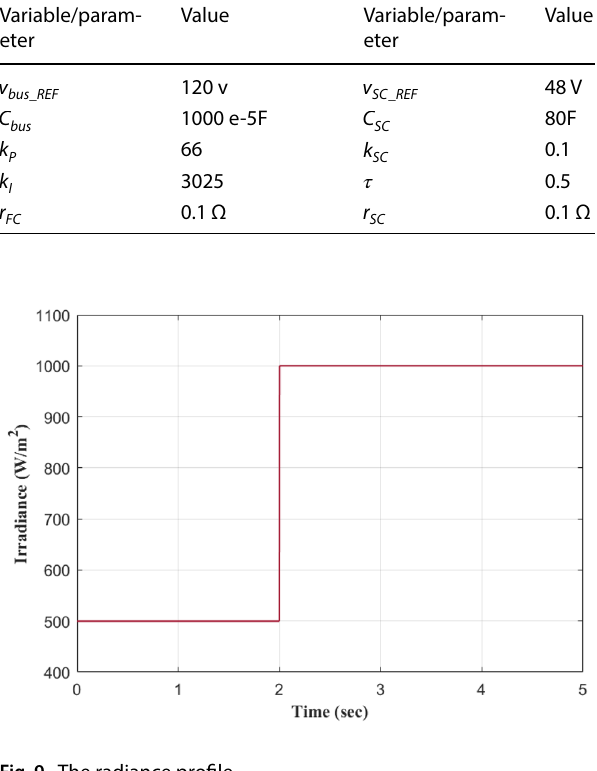
Fig. 9 The radiance profile